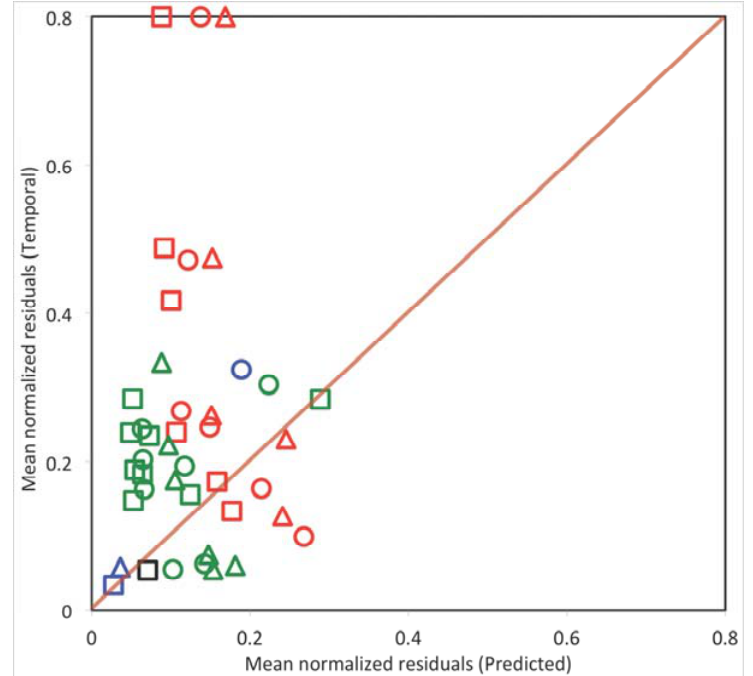
Figure 4. Scatterplot of 67 image-level predicted and temporal mean normalized residuals for the four study sites: red (Kansas); blue (Mozambique); green (Arizona); black (Manitoba). Symbols indicate the number of time steps away of the synthetic image from the last Landsat observation: one time step observation, k + 1, (square); two time steps, k + 2, (triangle); three time steps, k + 3, (circle). Points with very high mean normalized values in the temporal axis indicate the presence of undetected